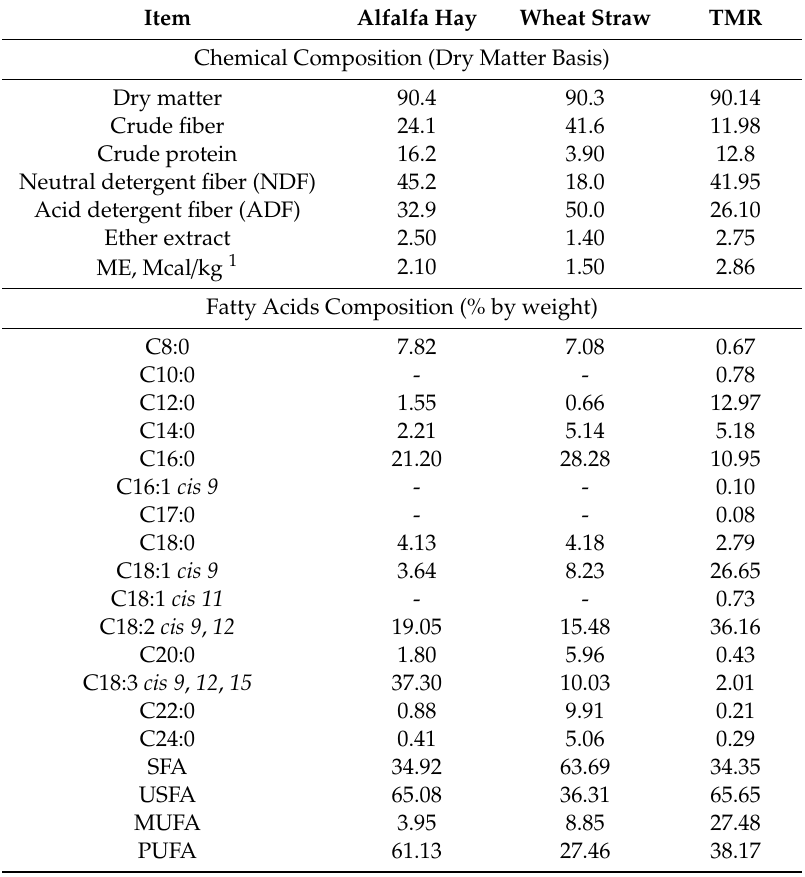
Table 1. Chemical composition and fatty acid profiles of the experimental diet. Item Alfalfa Hay Wheat Straw